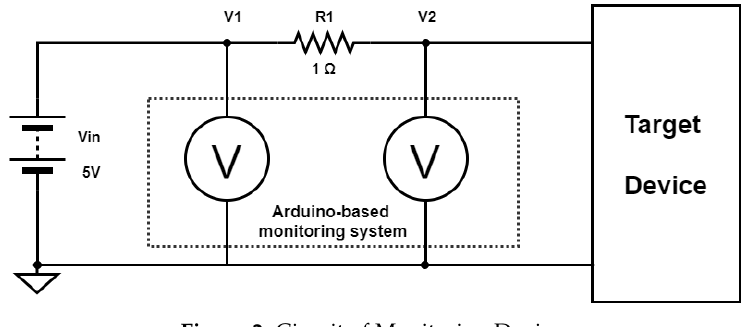
Figure 2. Circuit of Monitoring